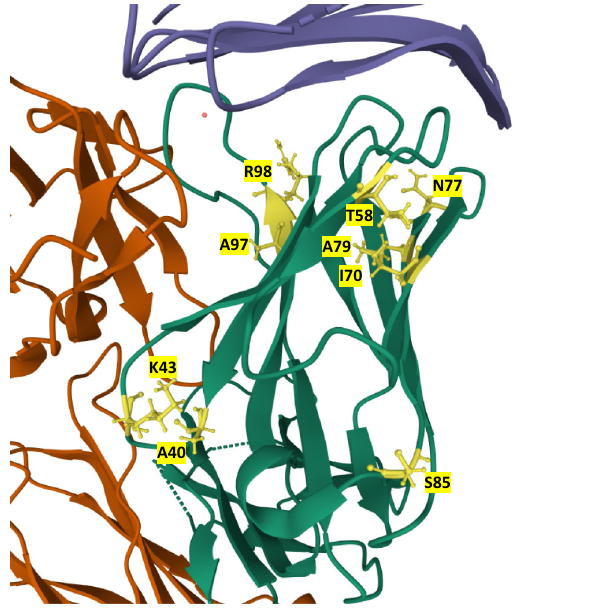
Fig. 7 | The locations of mutations in the PD-L1-Atezolizumab complex. Loca- tion of mutations in the 21 mutants in the structure of the Atezolizumab heavy chain. Mutated residues are labeled and colored in yellow in the heavy chain (green). PD-L1 is colored blue while the light chain is orange. Structure from RCSB Protein Data Bank (5XXY) in Mol* Viewer 45,71